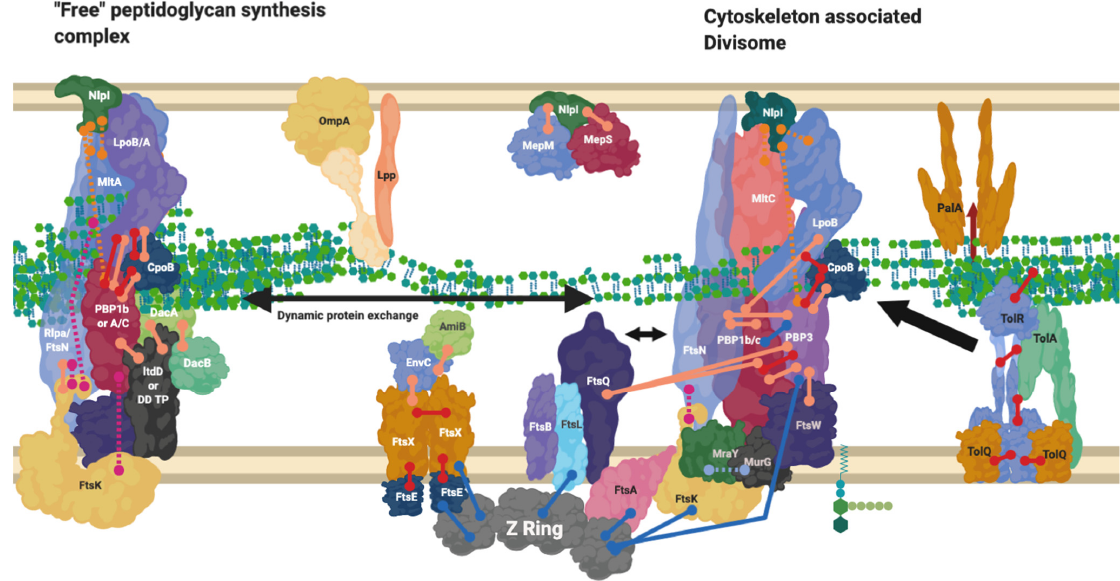
Figure 7. Divisome interaction network at the mature divisome. A diagram representing the interactions of the divisome proteins. Certain proteins within the divisome interact directly with the FtsZ filament. Localisation dependent studies have shown the enzymes co-localise at the FtsZ filament or in the pre-septal region (PIPs). Models suggest interactions are only brief [44]. This diagram is one of many possible configurations based on the current data. Diagram rendered using BioRender. Connections: Purple [57], Red [9,23,31] Cyan [53] Orange [54], Pink [58], Peach [9,29,47,50,59,60], Blue